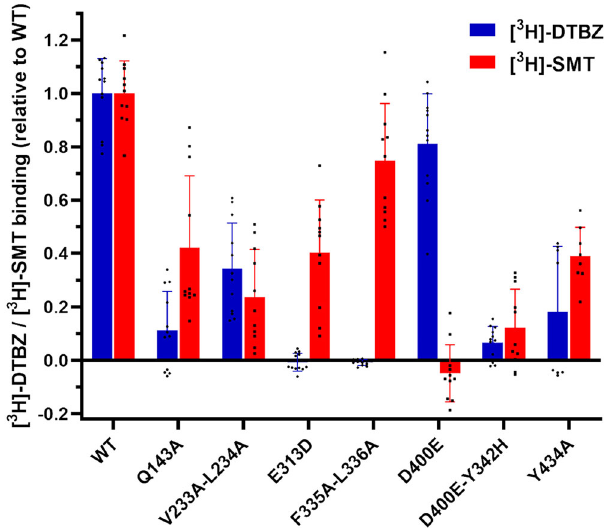
Fig. 6 [ 3 H]-DTBZ and [ 3 H]-SMT binding to VMAT2 mutants. Rat VMAT2-Strep-tagII wild-type (WT) and mutants were expressed in Hek293 cells, solubilized from membranes in detergents and bound to Strep-Tactin Sepharose beads. VMAT2-Strep-tagII bound beads were transferred to 96 well fi lter plates and assayed for [ 3 H]-DTBZ and [ 3 H]- SMT binding. Bars show results from three independent experiments with either three or four replicates, Y434A was repeated twice with four replicates. [ 3 H]-DTBZ and [ 3 H]-SMT binding was correlated to the amount of VMAT2-Strep-tagII present in each sample, determined by SDS-PAGE and western blotting. Statistically signi fi cant differences from wild-type, as determined by one way ANOVA: Q143A, V233A-L234A, E313D, D400E- Y342H and Y434 mutants displayed differences in both [ 3 H]-DTBZ and [ 3 H]-SMT binding, p < 0.01. F335A-L336A abolished [ 3 H]-DTBZ binding ( p < 0.0001) and had a small but non-signi fi cant decrease in [ 3 H]-SMT binding, while D400E abolished [ 3 H]-SMT binding ( p < 0.0001) and had a small but non-signi fi cant decrease in [ 3 H]-DTBZ binding.